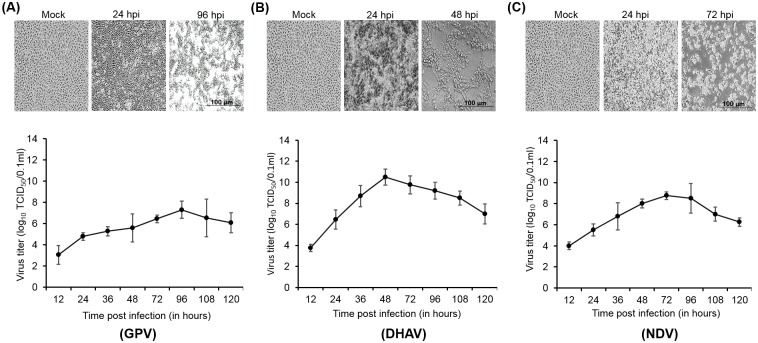
Susceptibility of the GEE cell line to GPV, DHAV and NDV infection.The CPEs following GPV, DHAV and NDV infection of the GEE cell line in the presence of uninfected cells as a mock were evaluated (A, B, and C; upper panel, respectively). Extensive CPEs associated with a rounding of the cells and destruction of the monolayer was observed at 96, 48, and 72 hpi with GPV, DHAV and NDV, respectively. Kinetics analysis of GPV-, DHAV- and NDV-infected GEE cells (A, B, and C; lower panel, respectively). Supernatant from infected cells with respective viruses was collected at diffident time points and titers of each virus were determined using TCID50 assay. The data are the Mean ± S.E. from three independent experiments.